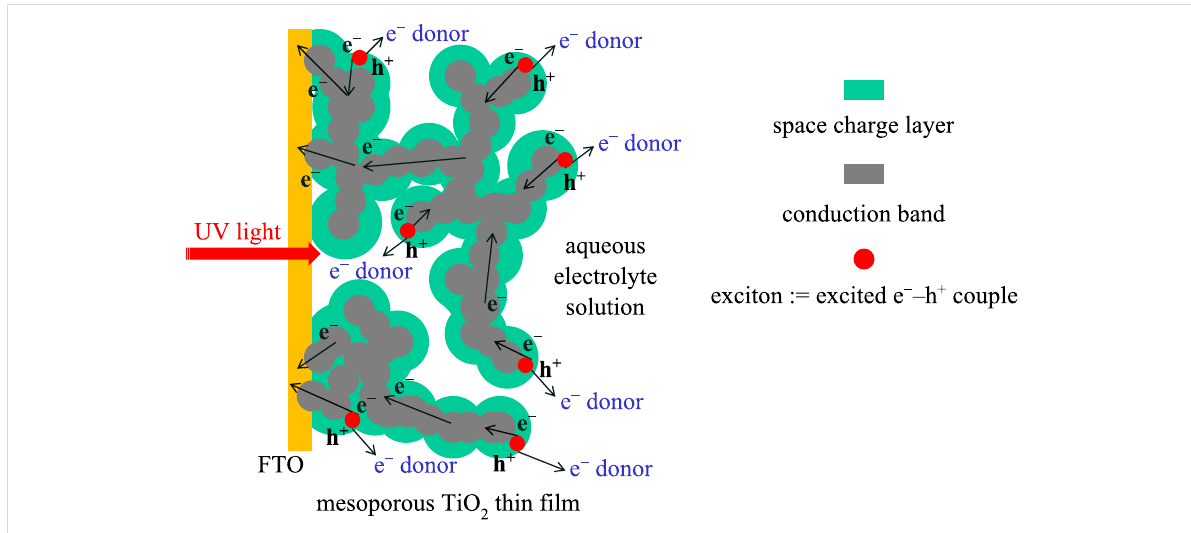
Figure 5: Schematic representation for the formation of continuous Schottky junctions with space charge layer (i.e., depletion layer, green region) and conduction band (CB, gray region) in a nanoporous n-TiO 2 thin film formed at the interface with an aqueous electrolyte solution containing an elec- tron donor. In the space charge layer holes (h + ) of the excitons (excited e − –h + couples, red circle) migrate in the VB onto the TiO 2 surface reacting with the e − donor, and electrons (e − ) of the exciton migrate into the bulk CB where e − then migrate through TiO 2 grain boundaries and finally into the conductive layer on FTO. It should be noted that the 3-D structured nano-ordered thin film is shown as a 2-D picture here.